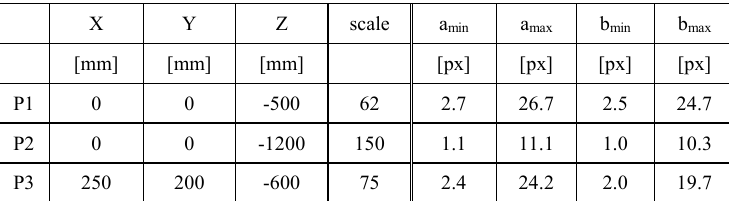
Table 1: Object point coordinates, imaging scale and resulting semi-axes for video camera setup